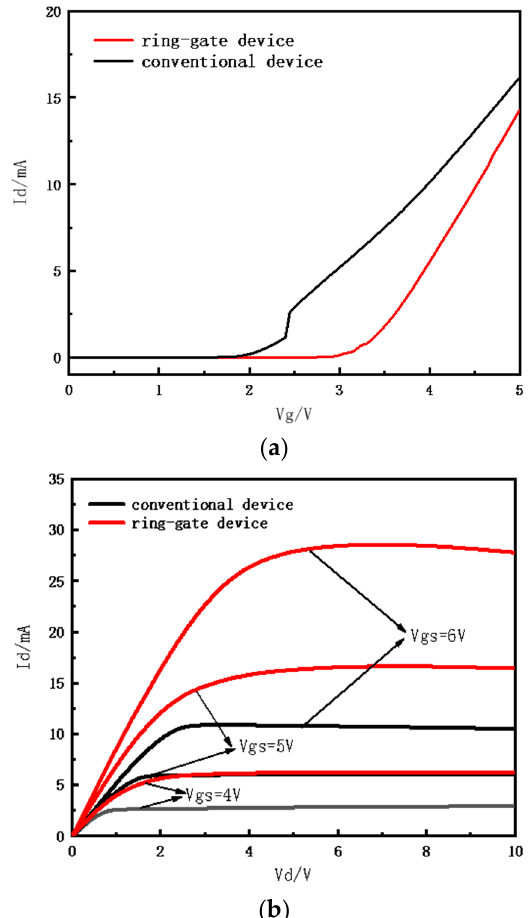
Figure 4. ( a ) Comparison of transfer characteristics between conventional and ring-gate HEMT devices. ( b ) Comparison of output characteristics between conventional and ring-gate HEMT devices.